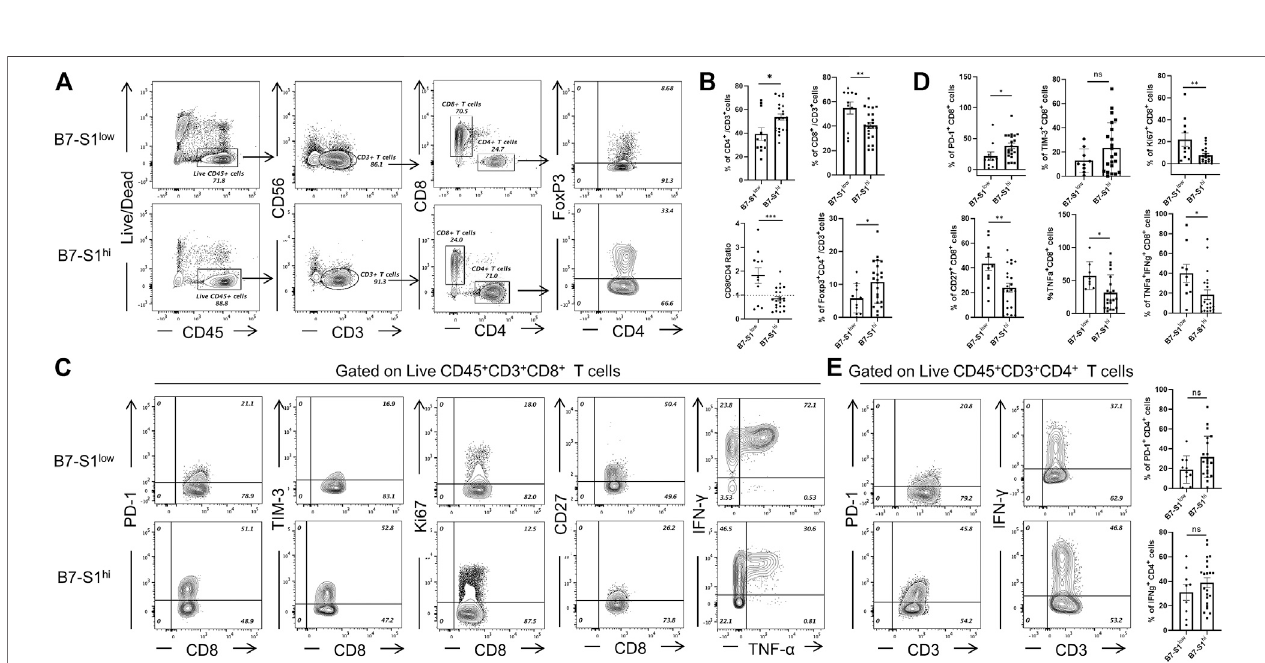
FIGURE 3 | B7S1 expression was inversely correlated with the cytolytic function of CD8+ TILs. (A,B) Representative fi gures and summarized data of in fi ltrated TcellsintumortissuesofpatientswithOvCainB7S1 hi andB7S1 low groups. (C,D) Representative fi guresandsummarizeddatadisplayingPD-1,Ki67,CD27,TNF α ,and IFN γ expression inCD8 + Tcellsin tumors. (E) Representative fi gures and summarized datadisplayingPD-1and IFN γ expression inCD4 + Tcells intumors.The dataare presented as means ± standard errors of the means; p value was computed by t -test. ns P > 0.05, * p < 0.05, ** p < 0.01, and *** p < 0.001.